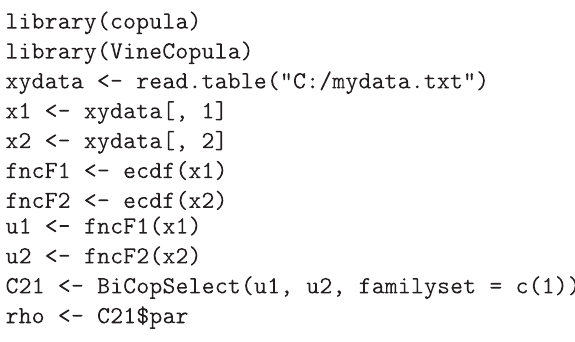
Table 2. All of the results reported in this table were directly obtained from a Octave/Matlab program with the exception of the dimensionless correlation coef fi cient r ( A , l ) as the available number of Monte Carlo simulation 0 events at M = 1000 was too small to obtain meaningful statistical results with the use of equation (11).